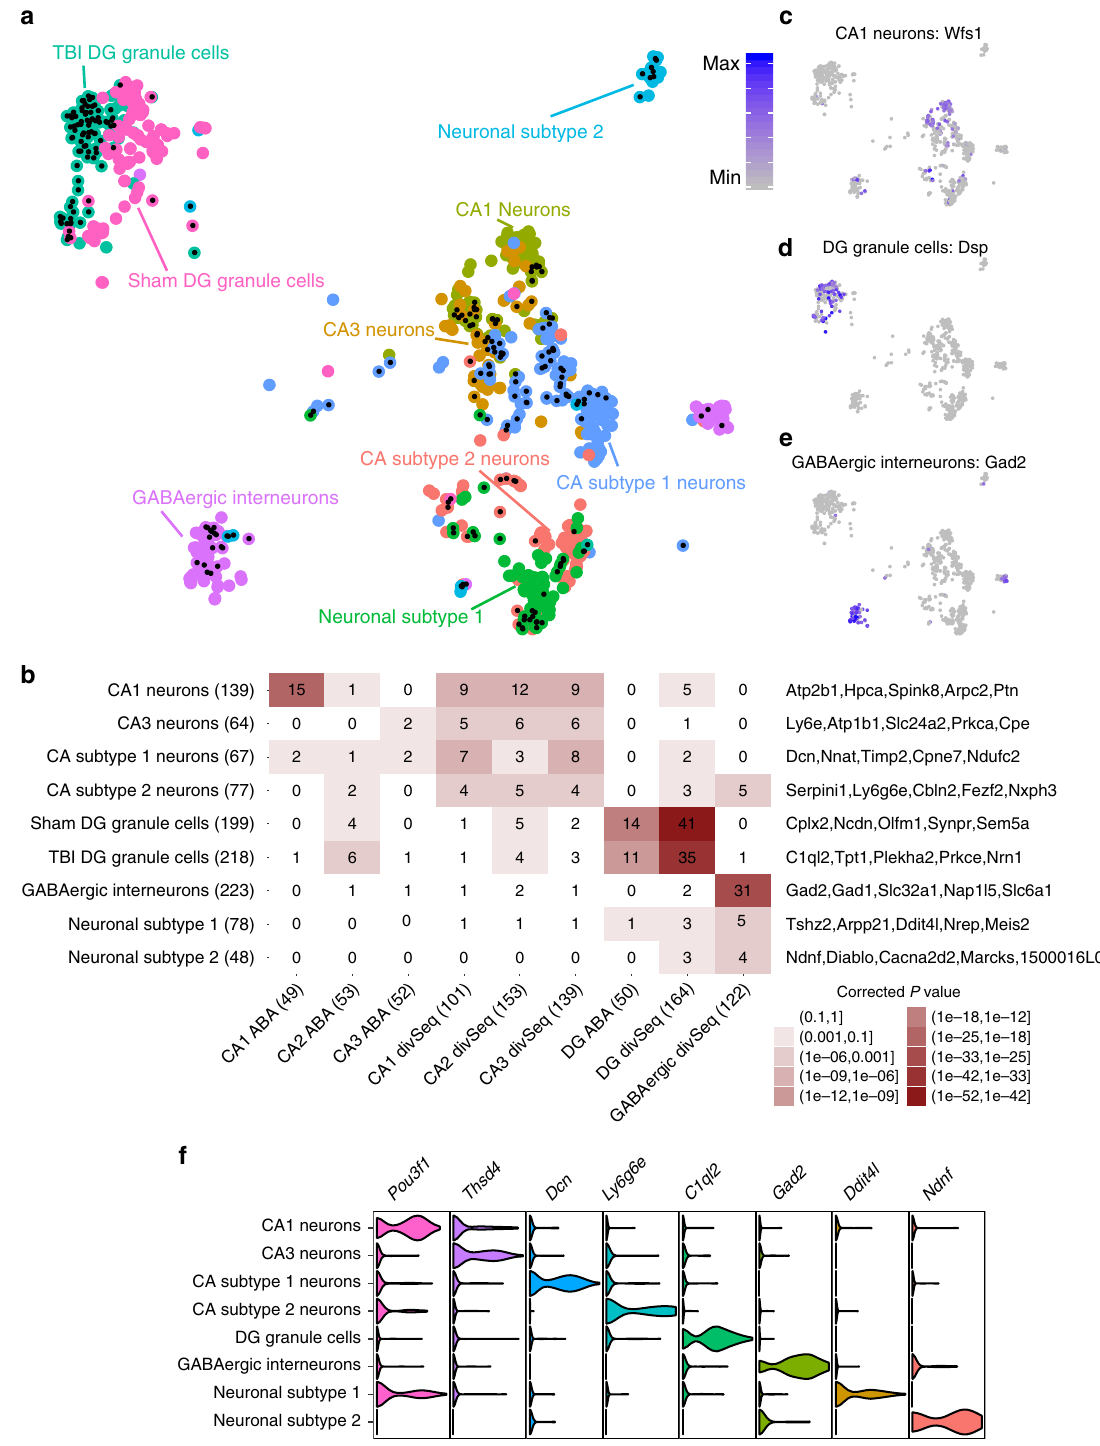
Fig. 3 Determination of neuronal cell subtypes and cell type-speci fi c gene markers. a t-SNE plot of neuronal subtypes determined by backspin biclustering. Each color indicates a different cell type cluster identi fi ed, and cells with a black dot at their center are from TBI samples. b Overlap of Drop-seq de fi ned marker genes of the neuronal subtypes (rows) with those of the previously de fi ned hippocampal neuronal cell types (columns). Known markers were derived from Alan Brain Atlas (ABA) 58 and Habib et al. using Div-Seq 15 . Signature marker numbers are indicated in the parenthesis. Fisher ’ s exact test is used to test enrichment with Bonferroni adjusted p values reported. Statistical signi fi cance of overlap is indicated by color (the darker the more signi fi cant), and the numbers of overlapping genes between our Drop-seq de fi ned markers and previously known markers are shown in the cells. Top cell marker genes determined by our Drop-seq data are listed on the right of the plot. c – e Cluster-speci fi c expression of known cell markers: CA1 neurons — Wfs1 , DG granule cells — Dsp , and GABAergic interneurons — Gad2 . f Normalized expression values of top neuronal subtype-speci fi c marker genes are plotted as violin plots with cell types as rows and genes as